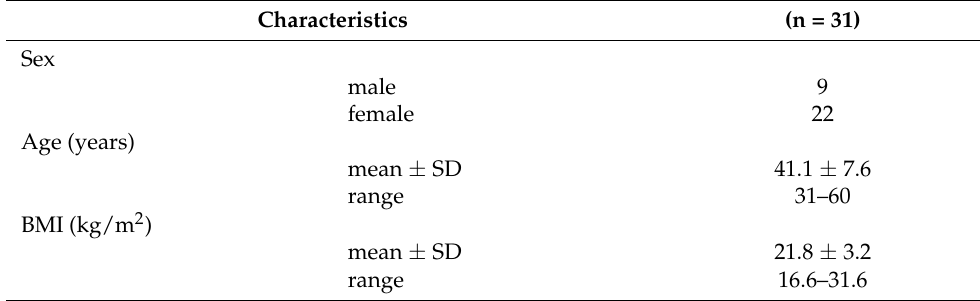
Table 1. Study subject